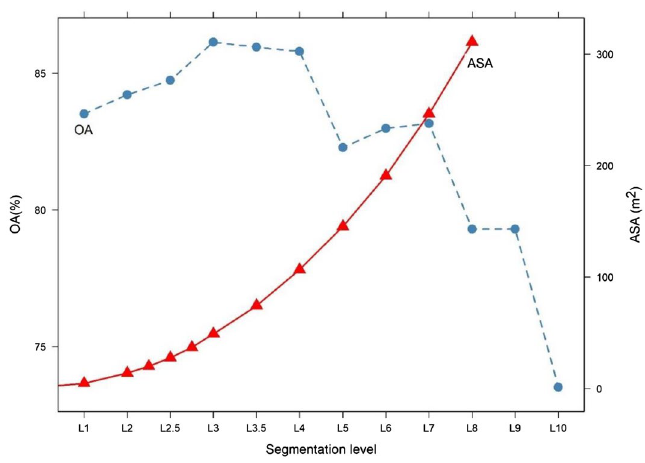
Figure 4. Relationship of segmentation levels, average segment areas (ASA), and overall accuracies (OA).